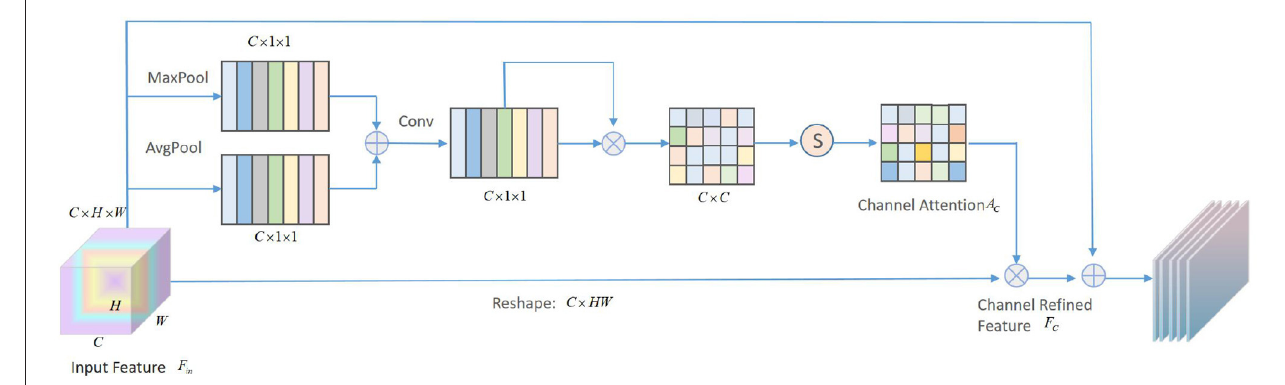
FIGURE 4 | Schematic diagram of Channel attention module.